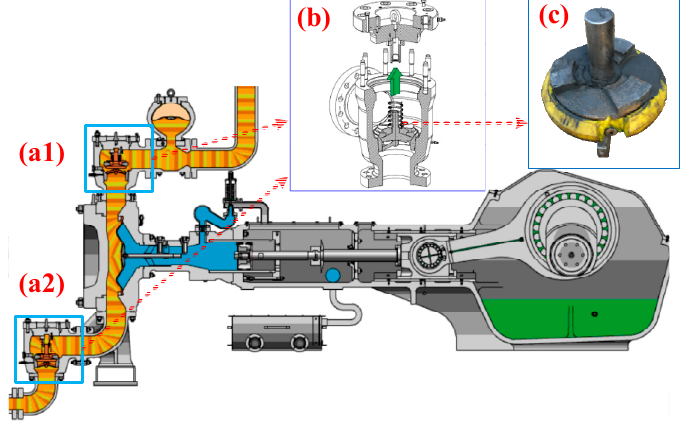
Figure 8. The structure of the diaphragm pump and check valve. ( a1 ) discharge check valve; ( a2 ) feed check valve; ( b ) structure of check valve; ( c ) a valve core that has been punctured.